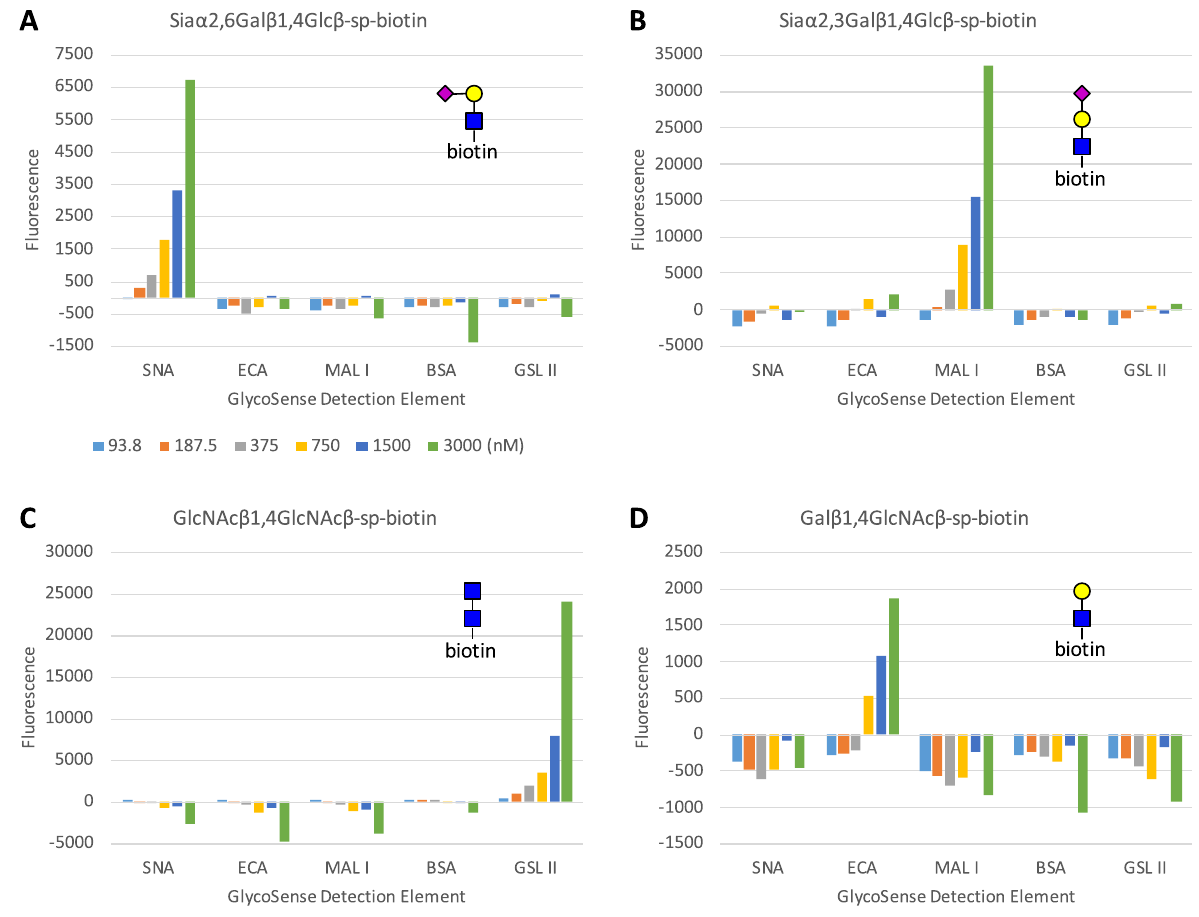
Figure 3. Binding of multiplex GlycoSense bead sets to biotinylated glycan standards conjugated to anti-biotin Fab labeled with DyLight 488. ( A ) SNA beads bind specifically to Siaα2,6Galβ1,4Glc. ( B ) MAL I beads bind specifically to Siaα2,3Galβ1,4GlcNAcβsp-Biotin. ( C ) GSL II beads bind specifically to GlcNAcβ1,4GlcNAc. ( D ) ECA-conjugated beads bind specifically to Galβ1,4GlcNAc. One analysis per concentration was performed